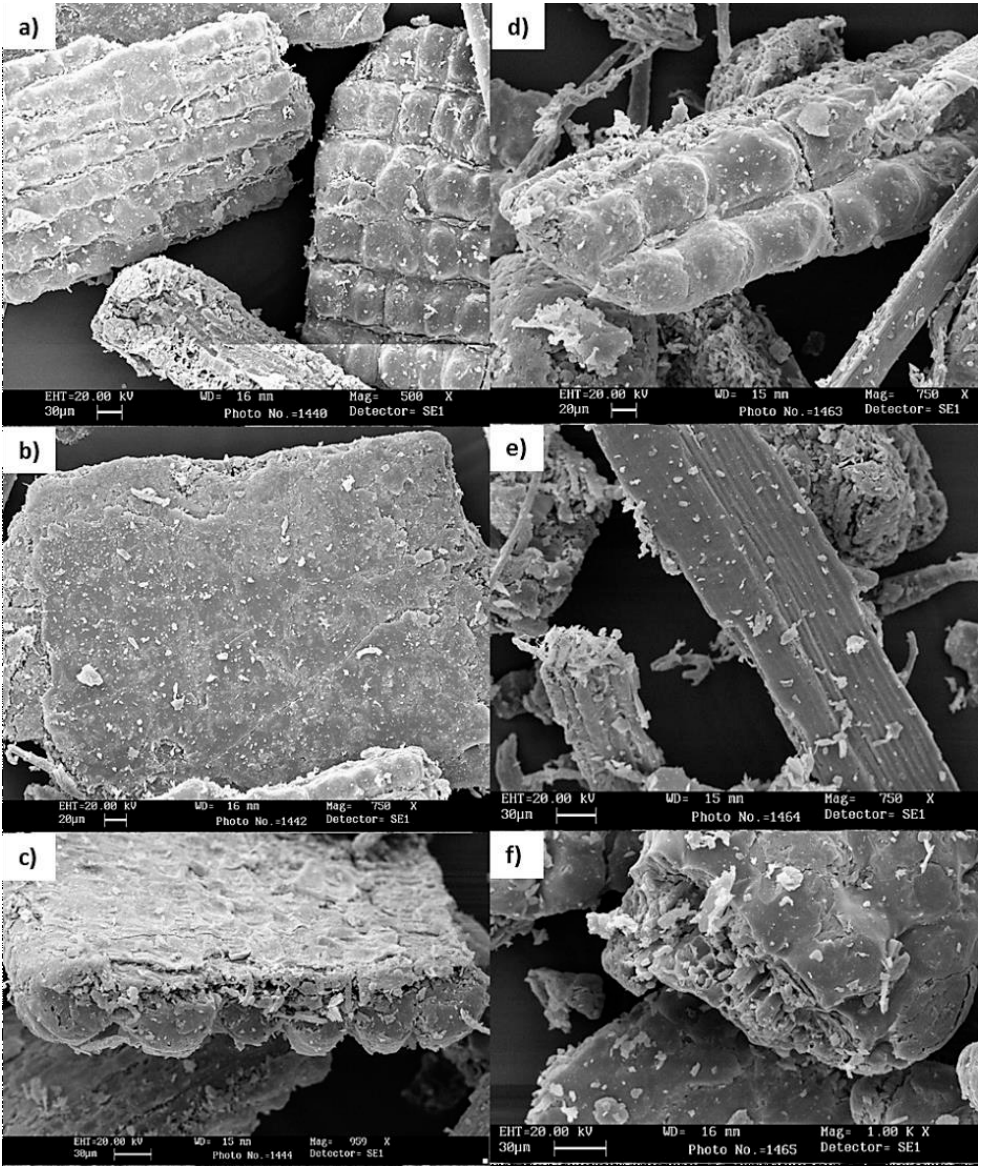
Figure 2. SEM images of: ( a – c ) Milled rice husk with particle size 200–400 µm; ( d – f ) milled rice husk with particle size 100–200 µm.